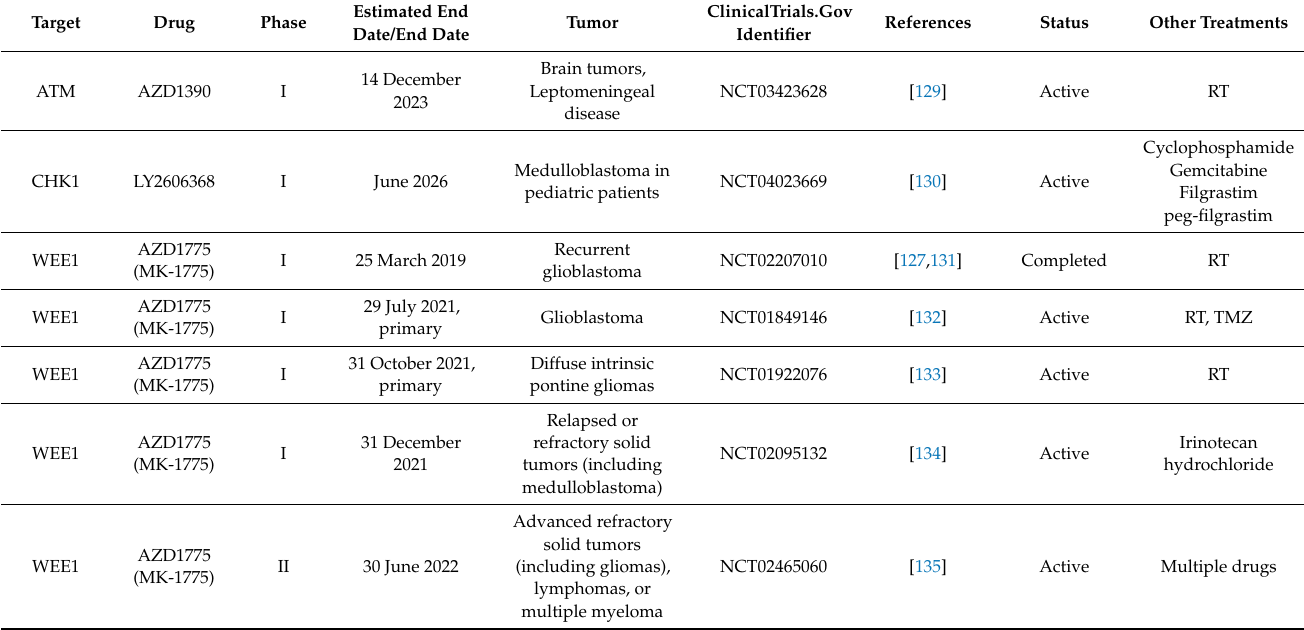
Table 2. Clinical trials involving inhibitors of ATM, CHK1, and WEE1 in brain tumors